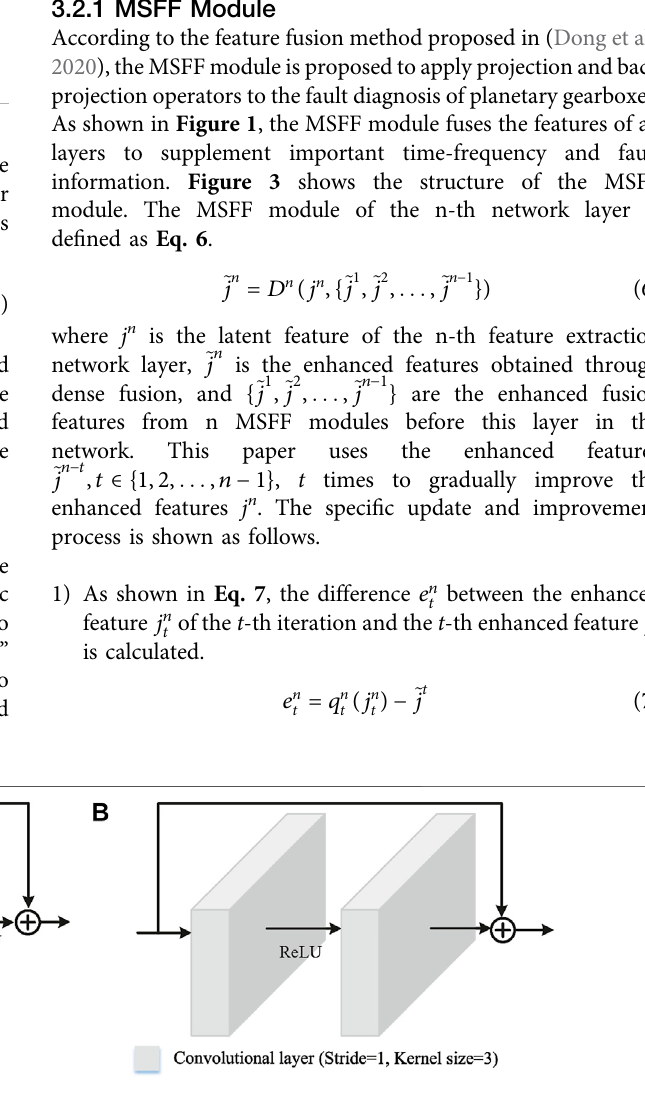
FIGURE 2 | Structure of residual group. (A) Residual group (B) Residual